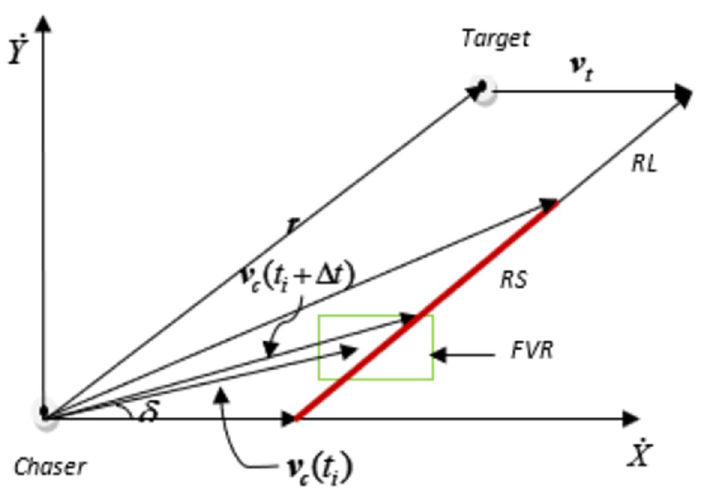
Fig 2. Construction of Rendezvous